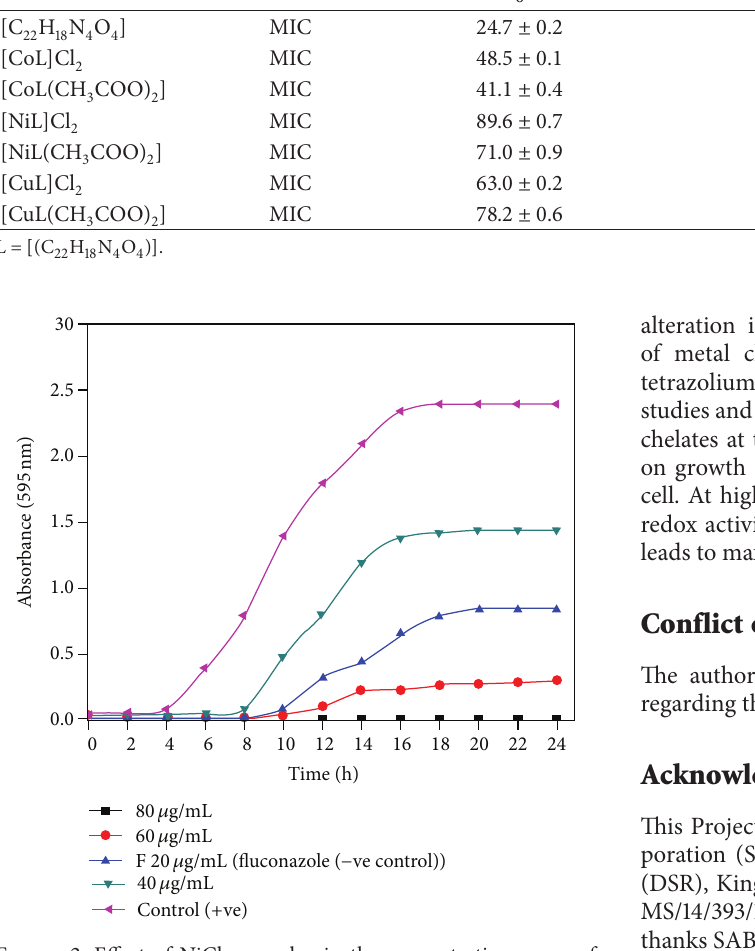
Figure 2: Effect of NiCl 2 complex in the concentration range of 40–80 𝜇 g/mL was studied on C. albicans STD 31. Growth curve plotted against absorbance at 595 nm and time (h) shows complete inhibition of growth at 80 𝜇